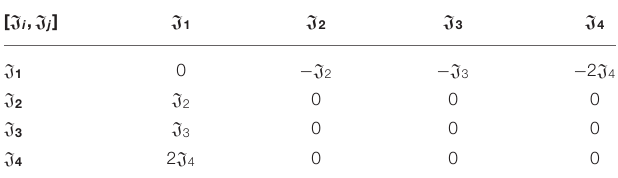
TABLE 1 | Commutator table of the vector fields of system (3).